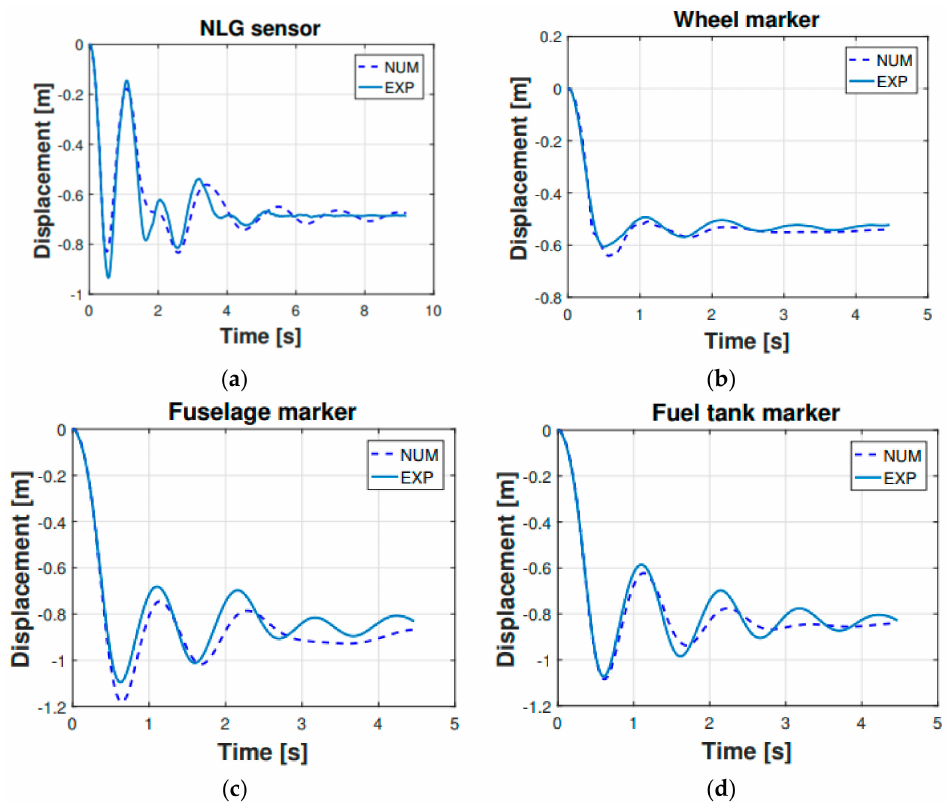
Figure 6. Numerical model (multibody) vs. experimental measurements of the vertical displacement for the 0.48 m drop. Displacement refers to sensors in Table 4.